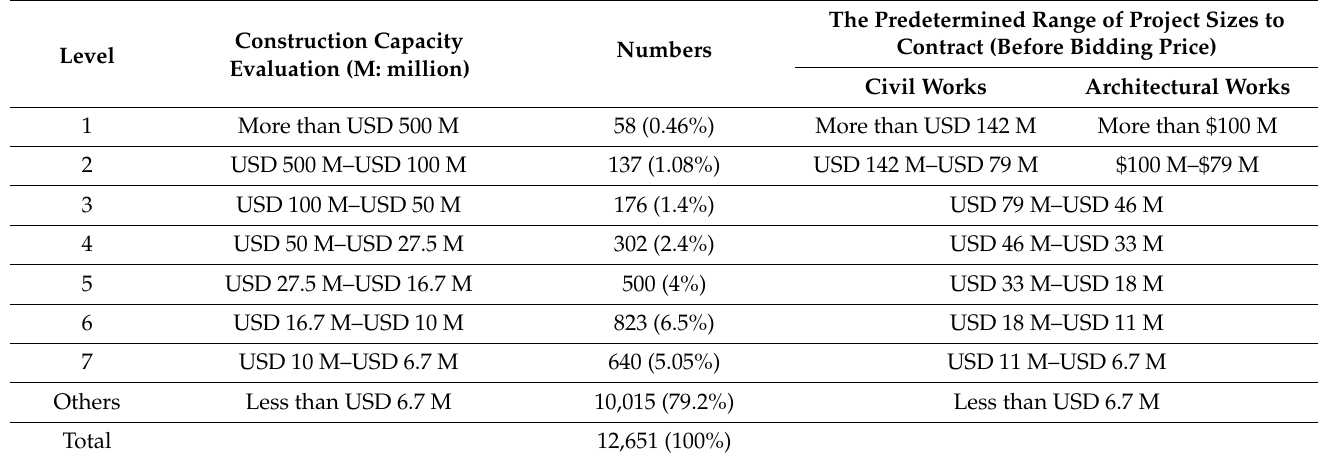
Table 3. The levels of construction capacity evaluation policy in Korea